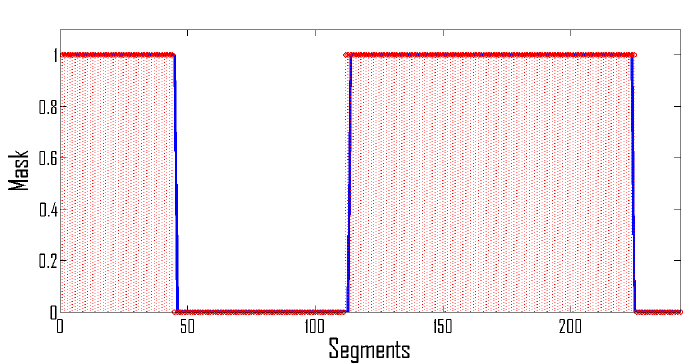
Figure 8. Original seizure mask (blue) vs. detected seizure